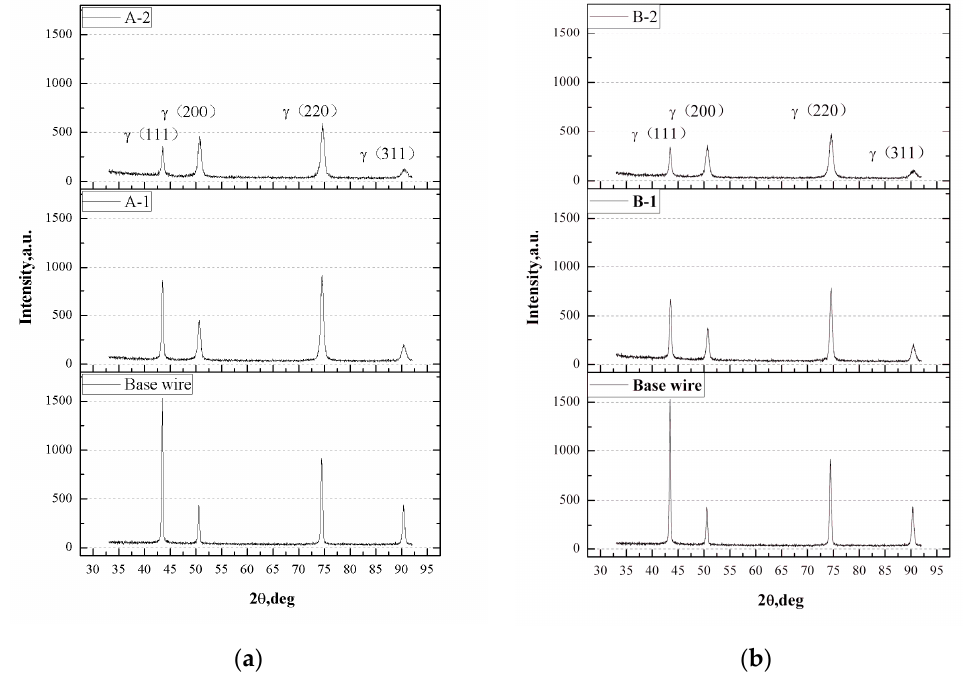
Figure 3. XRD patterns of two sets of drawn wires, XRD patterns of drawing process A ( a ) and B ( b ). The strength of the wires during the drawing process varied with changes in the area reduction. As shown in Figures 4 and 5, the nominal tensile strengths of the wires in both processes A and B increased for larger AR , which is the same trend as the true tensile stress.